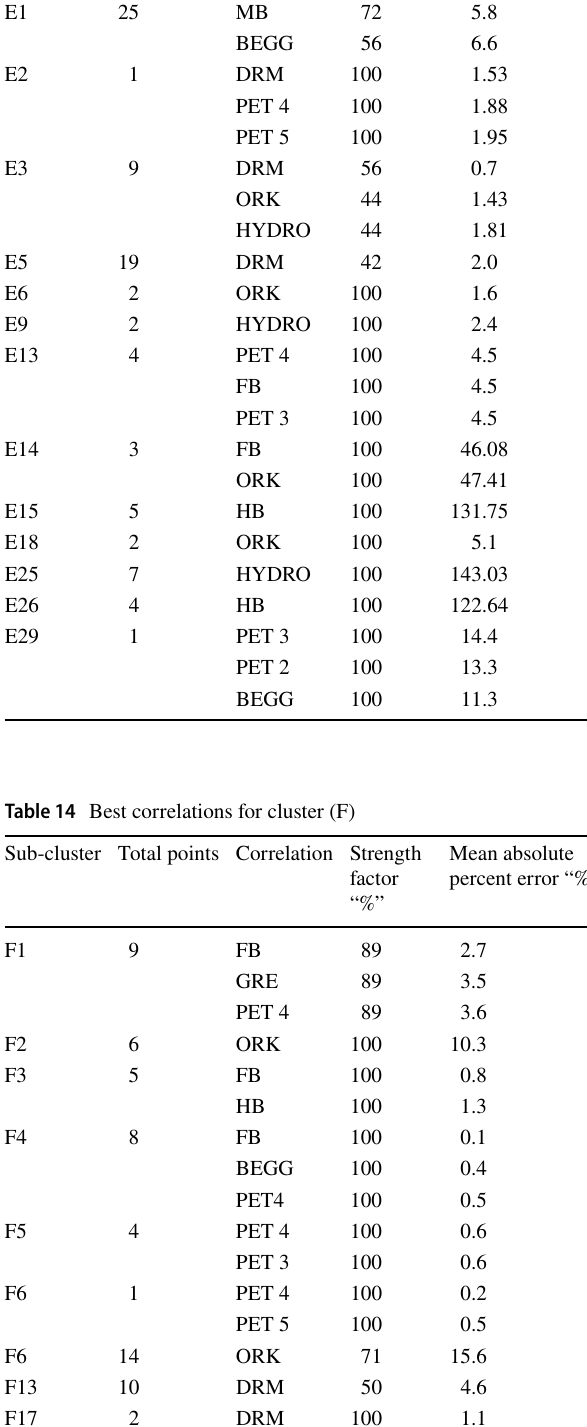
Table 15 Best correlations for cluster (G) factor